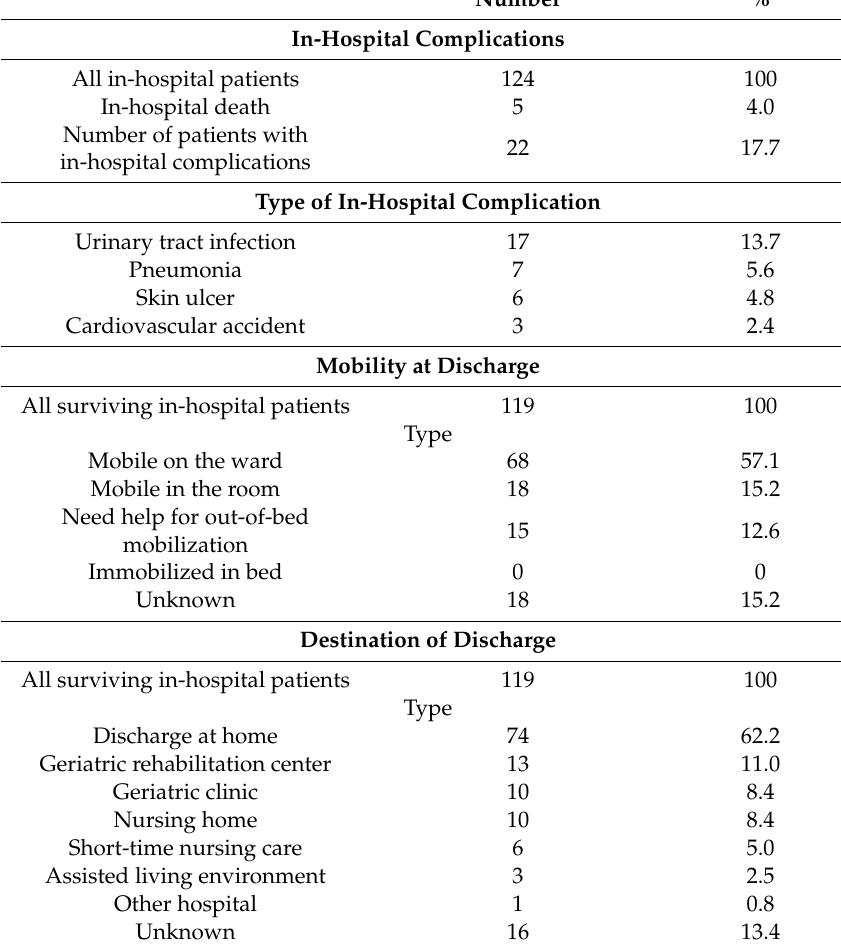
Table 3. In-hospital complications, mobility, and destination at discharge. Number